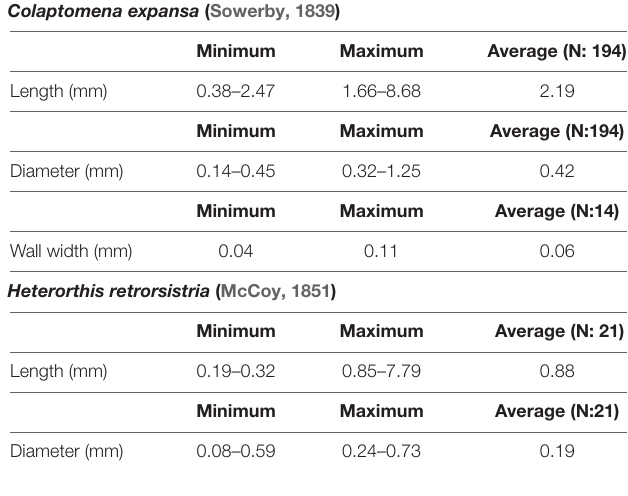
TABLE 1 | Dimensional parameters of Palaeosabella prisca on Colaptomena expansa and Heterorthis retrorsistria . Colaptomena expansa (Sowerby,